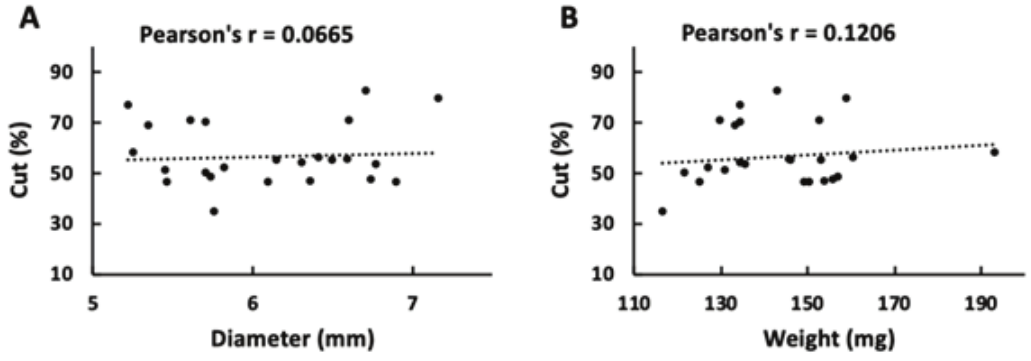
Figure 3. Correlations between the diameter (A) and weight (B) of the eyes and the percentage of cornea excised by the inner- stopper guarded trephine. The linear dependence was considered weak when the Pearson’s r value is below